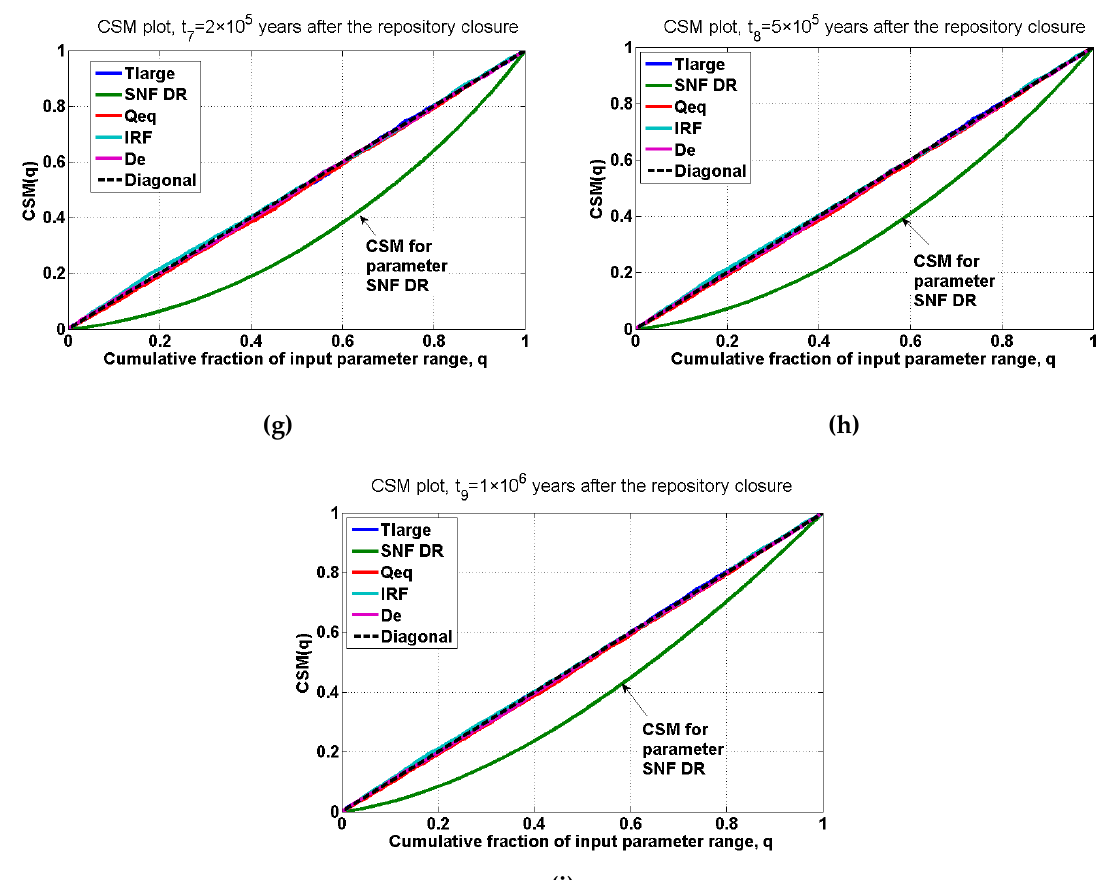
Figure 4. The CSM (contribution to the sample mean) plots for I-129 radionuclide flux into the geosphere (random sample size N = 1000) at di ff erent time points after the repository closure: ( a ) at 1 × 10 3 years after repository closure; ( b ) at 5 × 10 3 years after repository closure; ( c ) at 1 × 10 4 years after repository closure; ( d ) at 2 × 10 4 years after repository closure; ( e ) at 5 × 10 4 years after repository closure; ( f ) at 1 × 10 5 years after repository closure; ( g ) at 2 × 10 5 years after repository closure; ( h ) at 5 × 10 5 years after repository closure; ( i ) at 1 × 10 6 years after repository closure (Tlarge—defect size